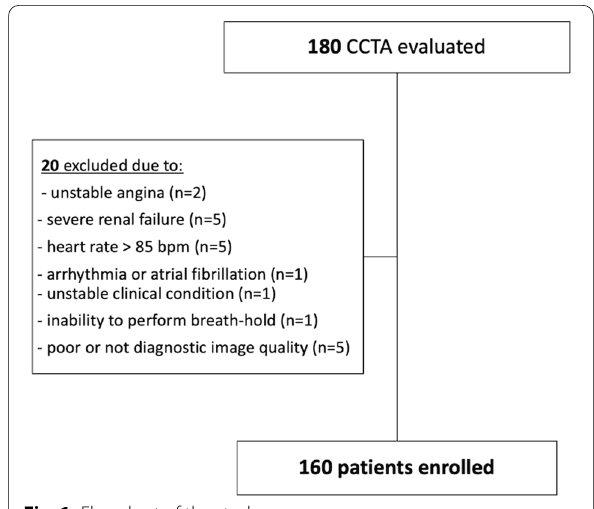
Fig. 1 Flowchart of the study